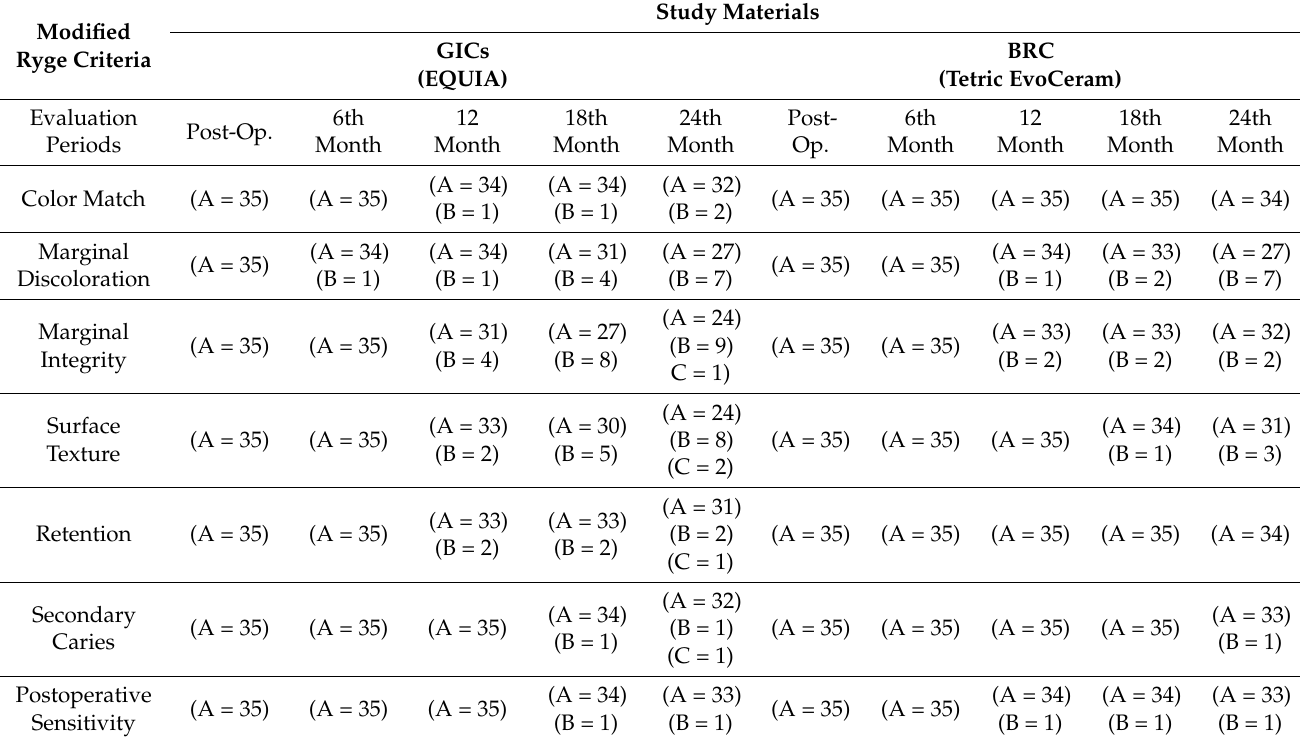
Table 4. The modified Ryge scores of restorations made with GICs and BRC applied in the study after treatment (post-op.), 6-month, 12-month, 18-month, and 24-month